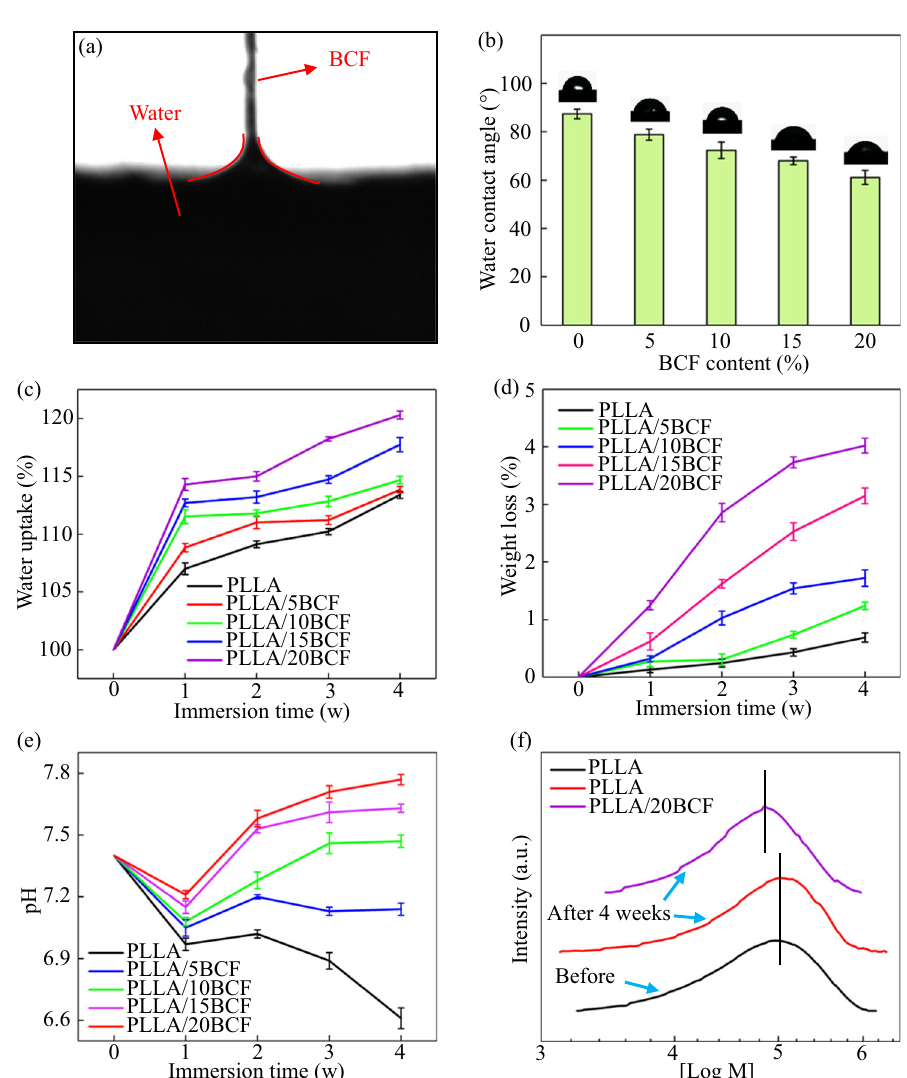
Fig. 2 Hydrophilic properties of the scaffolds. a the formation of capillary channel when BCF got to water surface, ( b ) water contact angles of the composite scaffold with different BCF content. c Water uptake, ( d ) weight loss and ( e ) pH variation of the composite scaffold with different BCF content during immersion in PBS, ( f ) change in M w and molecular weight distribution of neat and composite scaffold after immersion for 4 w. The error bars represent the standard deviations from four independent